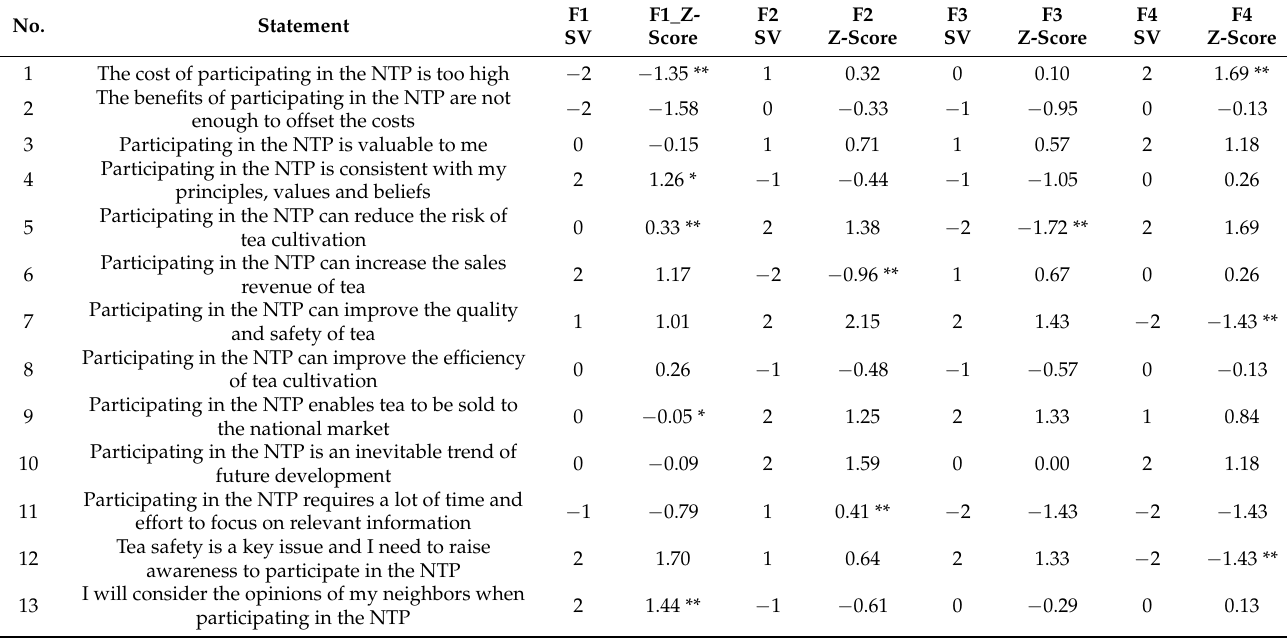
Table A3. Q-sort value and Z-score for four